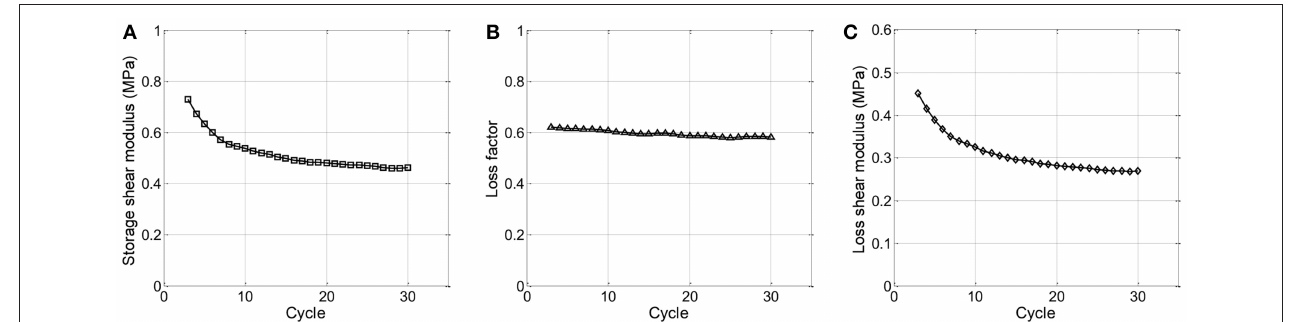
Frontiers in Materials |